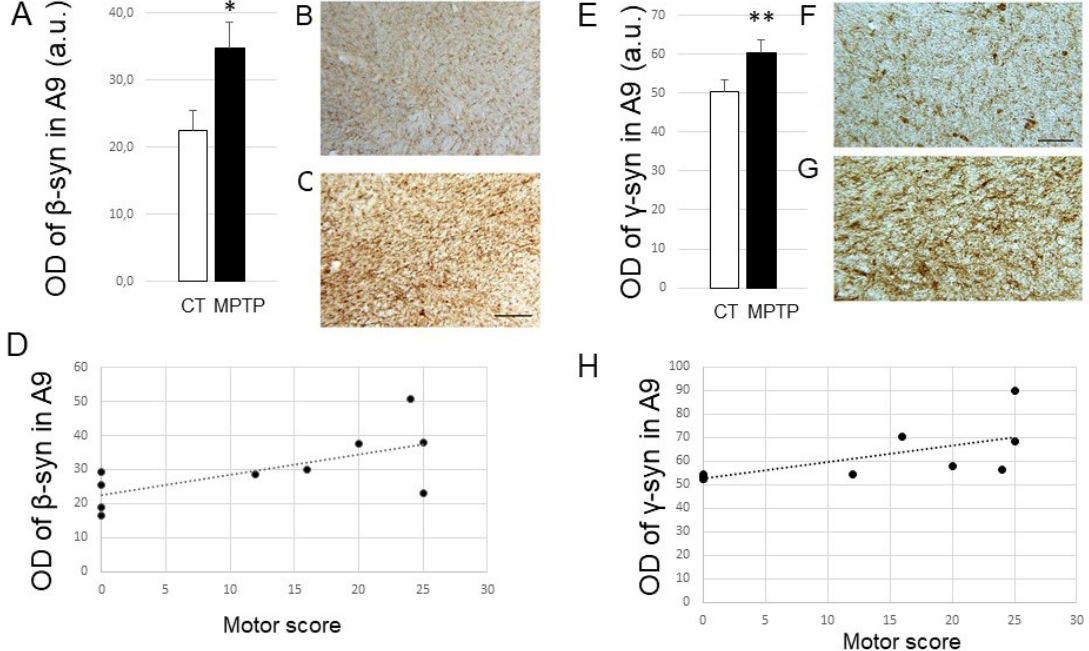
Figure 2. ( A ) Histogram represents optical density of β -syn (in arbitrary units) in A9 from control (CT, n = 5) and MPTP-intoxicated (MPTP, n = 6) animals. * p < 0.05 when compared to controls. ( B , C ) Photomicrographs at low magnification ( × 6.3) of coronal sections of a control (MF14) and an MPTP- intoxicated (MF18) Macaca fascicularis, exemplifying β -syn labeling obtained at the level of the sub- stantia nigra. Scale bar on C is 200 µm. ( D ) Positive correlation observed between the expression levels of β -syn (OD expressed in arbitrary units) in A9 and the maximal motor score exhibited by